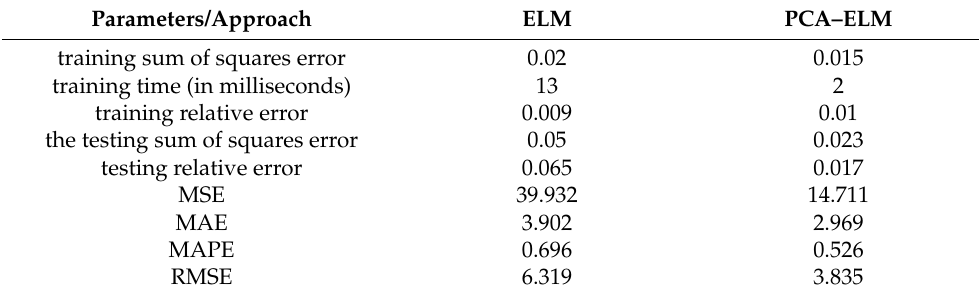
Table 2. ELM model and PCA–ELM integration model using a sigmoid activation function with 50 hidden neurons.